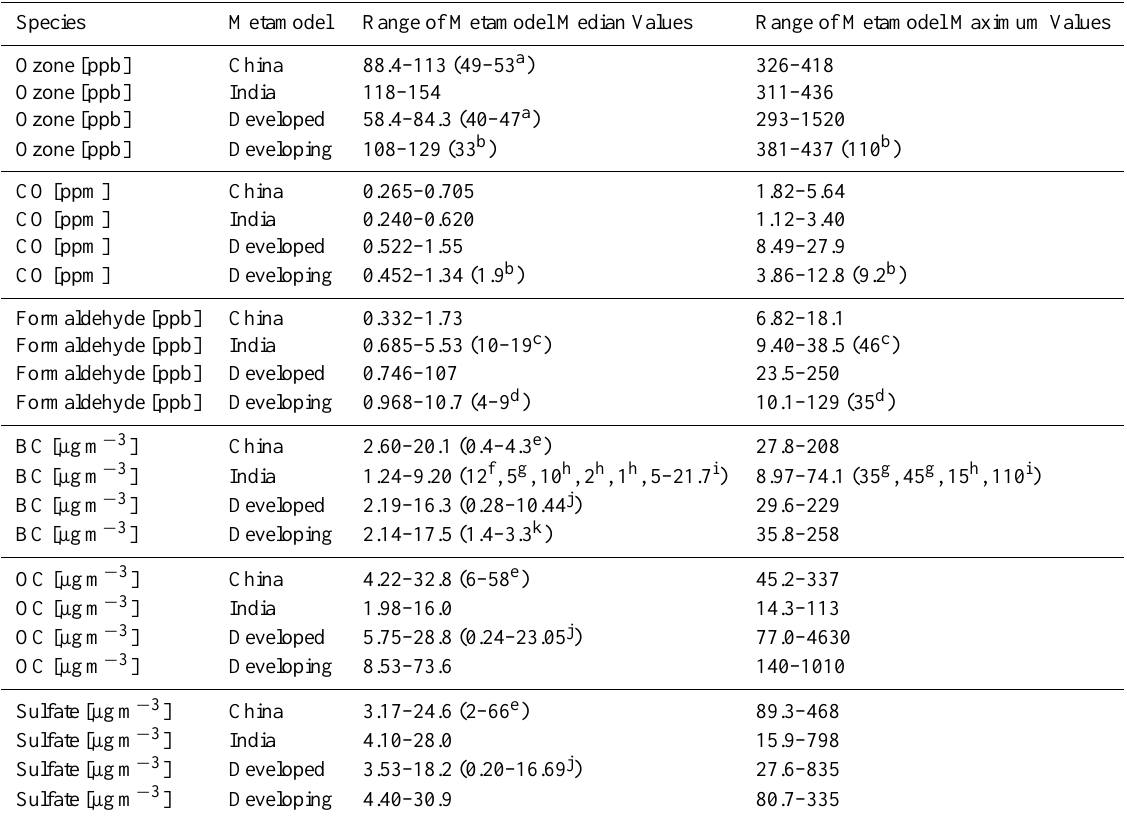
Table 9. Results of metamodel simulated urban area concentration medians (50% of results are above this value and 50% of results are below this value) and maxima, for each meteorology type,based on 50000 randomly selected input parameters. Where mentioned in the text, measurement values are included in parenthesis, and the citations are given according to the following list: a Ding et al. (2008), b Ramirez et al. (2009), c Dutta et al. (2009), d Lei et al. (2009), e Huang et al. (2010), f Badarinath et al. (2009), g Beegum et al. (2009), h Dutkiewicz et al. (2009), i Husain et al. (2007), j See et al. (2006), k Godoy et al.